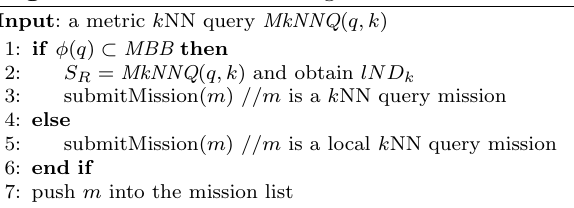
Fig. 5 Metric k NN